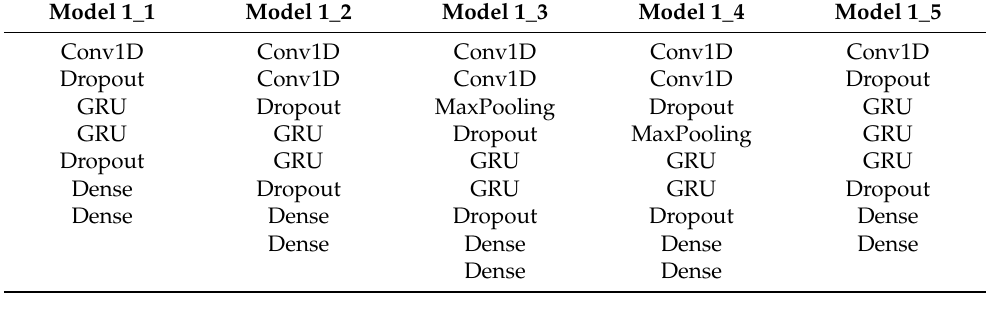
Table 1. Layers description for all models used in Experiment 1.